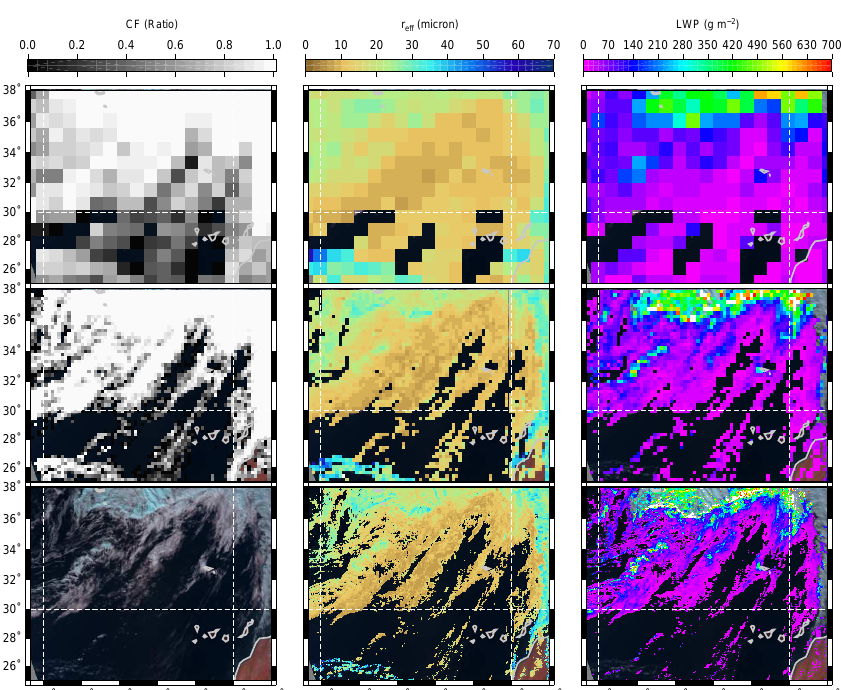
Fig. 1. Cloud fraction (CF), cloud droplet effective radius ( r eff ) and cloud liquid water path (LWP) for high and low clouds W and NW of the Canary Islands at spatial resolutions of 5km, 25km and 100km. The lower left-hand panel is a 1km resolution with a three-color rendering of the scene using three MODIS L1B bands: Band 3 (459–479nm), Band 4 (545–565nm), and Band 5 (1230–1250nm). The figure emphasizes the multi-layered nature of the cloudiness. Different spatial resolutions suggest different statistics of cloud properties.